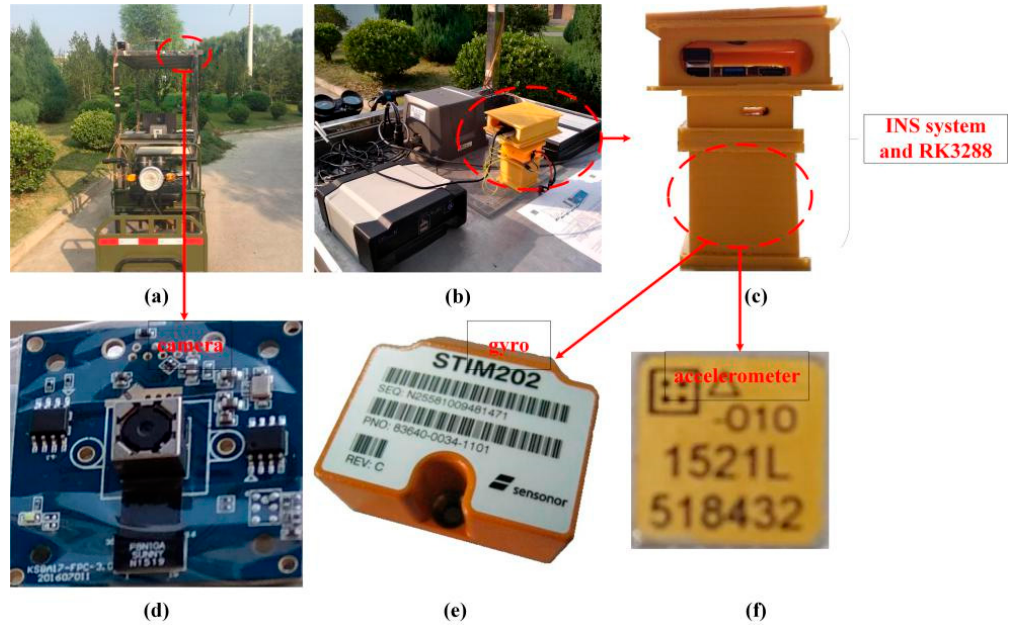
Figure 6. Vehicle testing platform. ( a ) Test vectors; ( b ) high-precision optical fiber inertial navigation/differential global positioning system (GPS) reference; ( c ) INS and LattePanda; ( d ) cameras; ( e ) STIM202 gyroscope; ( f ) 1521L single-axis accelerometer.